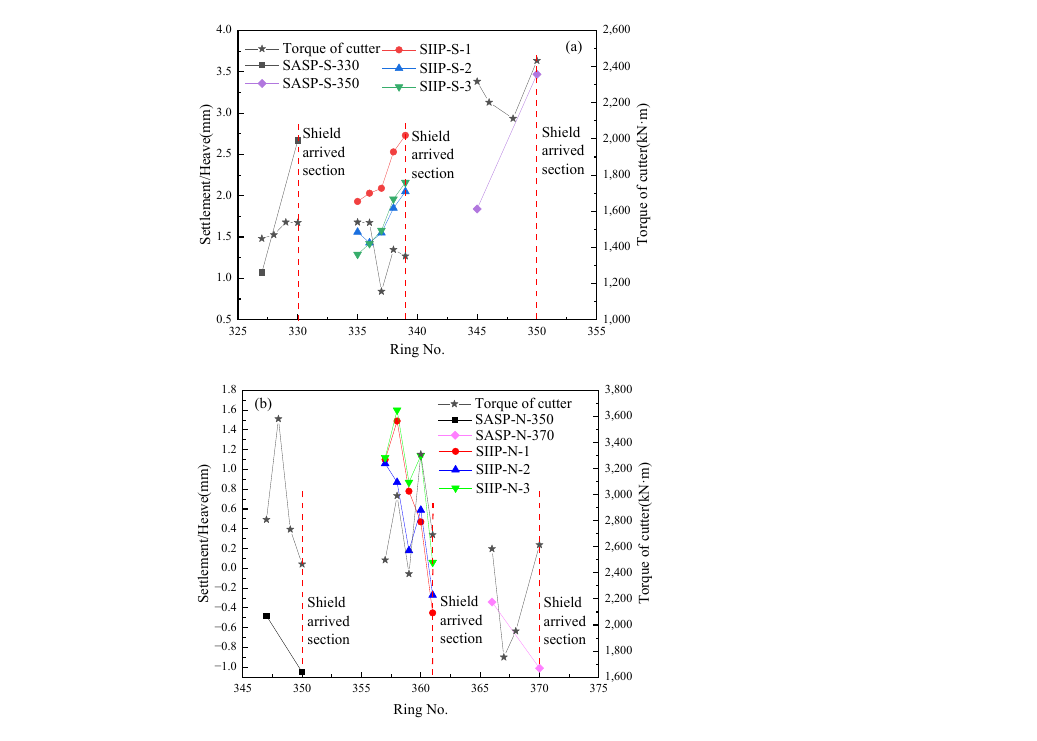
Figure 18. Influence of torque of the cutter on surface deformation: ( a ) south line; ( b ) north line. The torque of the cutter also has a high correlation with the thrust force in the soft soil area [23]. Therefore, the relationship between cutter torque and surface deformation is also positively correlated, which is consistent with the case of round gravel strata.